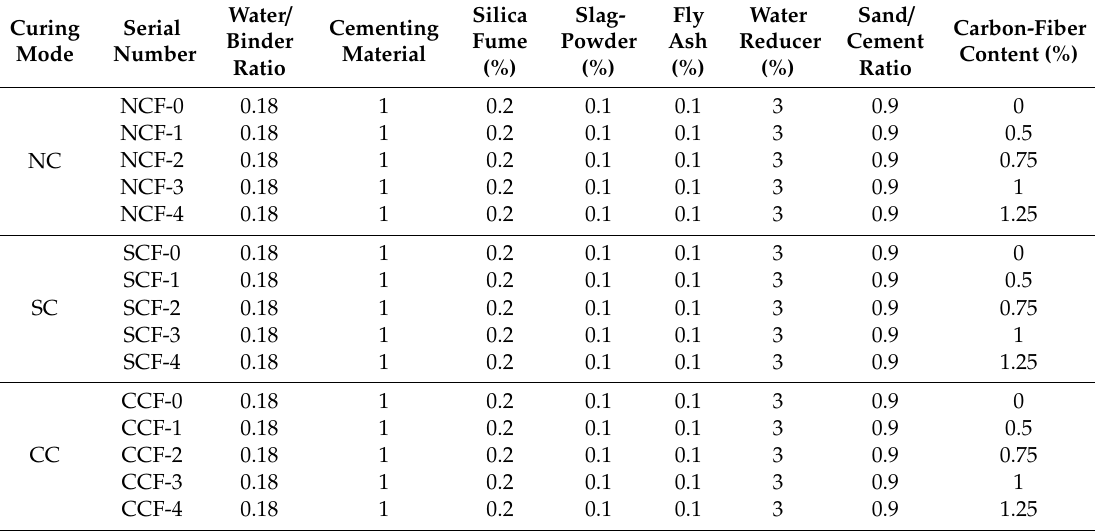
Table 6. Mix proportions of carbon-fiber reactive powder concrete (RPC).